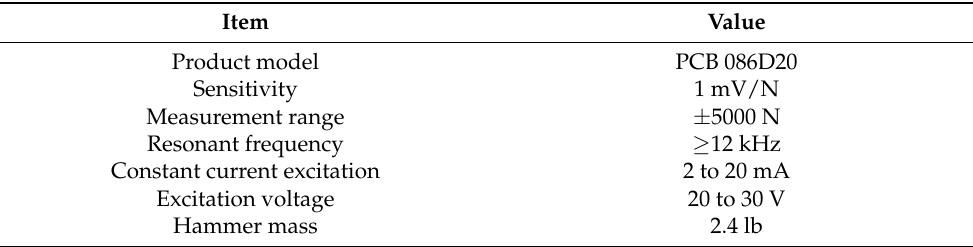
Table 1. Configuration parameters of the PCB impact hammer.